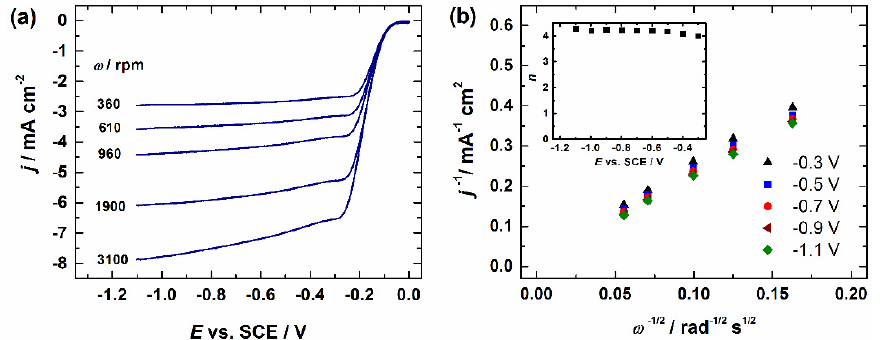
Figure 5. ( a ) RDE voltammetry curves of O 2 reduction on Glu-NC-8Co catalyst in O 2 -saturated 0.1 M KOH, ν = 10 mV s − 1 ; ( b ) Koutecky–Levich plots derived from data in ( a ) and number of electrons transferred (inset).